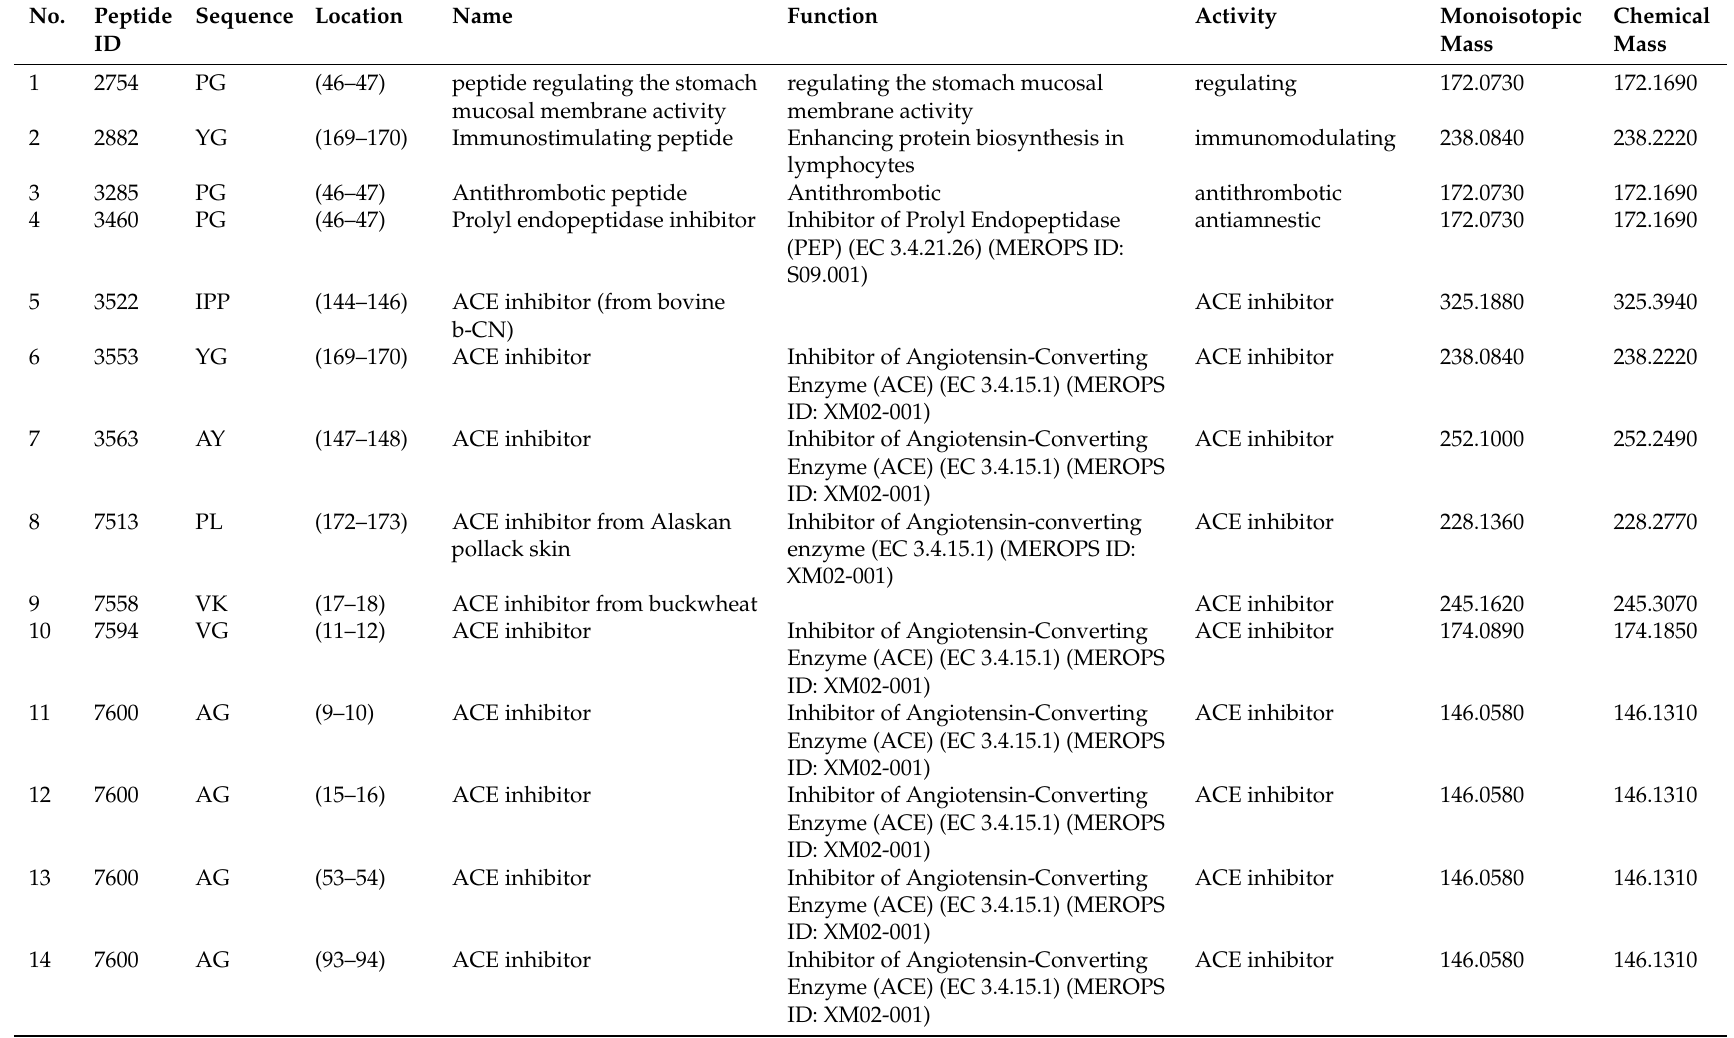
Table A41. Bioactive peptides from RubisCO of Halophila stipulacea . In silico enzymatic cleavage was carried out by using calpain